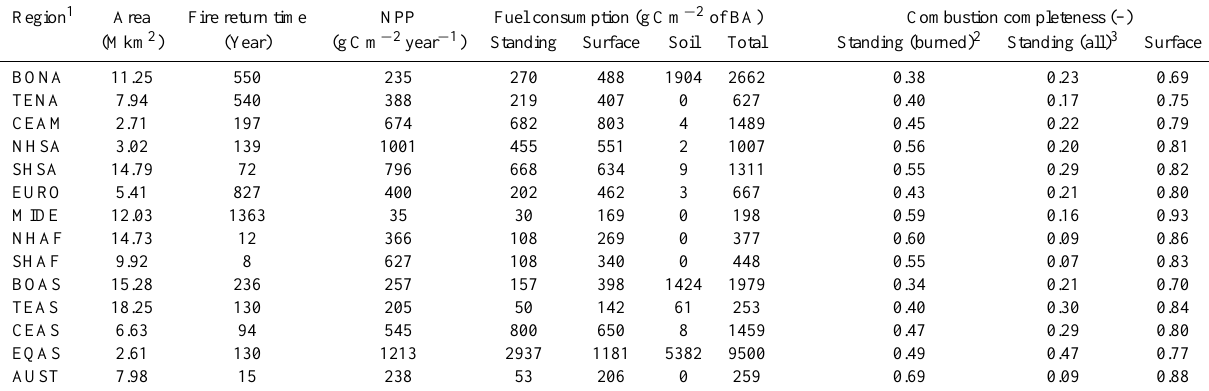
Table 4. 1997–2009 area-averaged fire return time, NPP, fuel consumption per unit area burned (BA), and combustion completeness for different regions. Region 1 Area